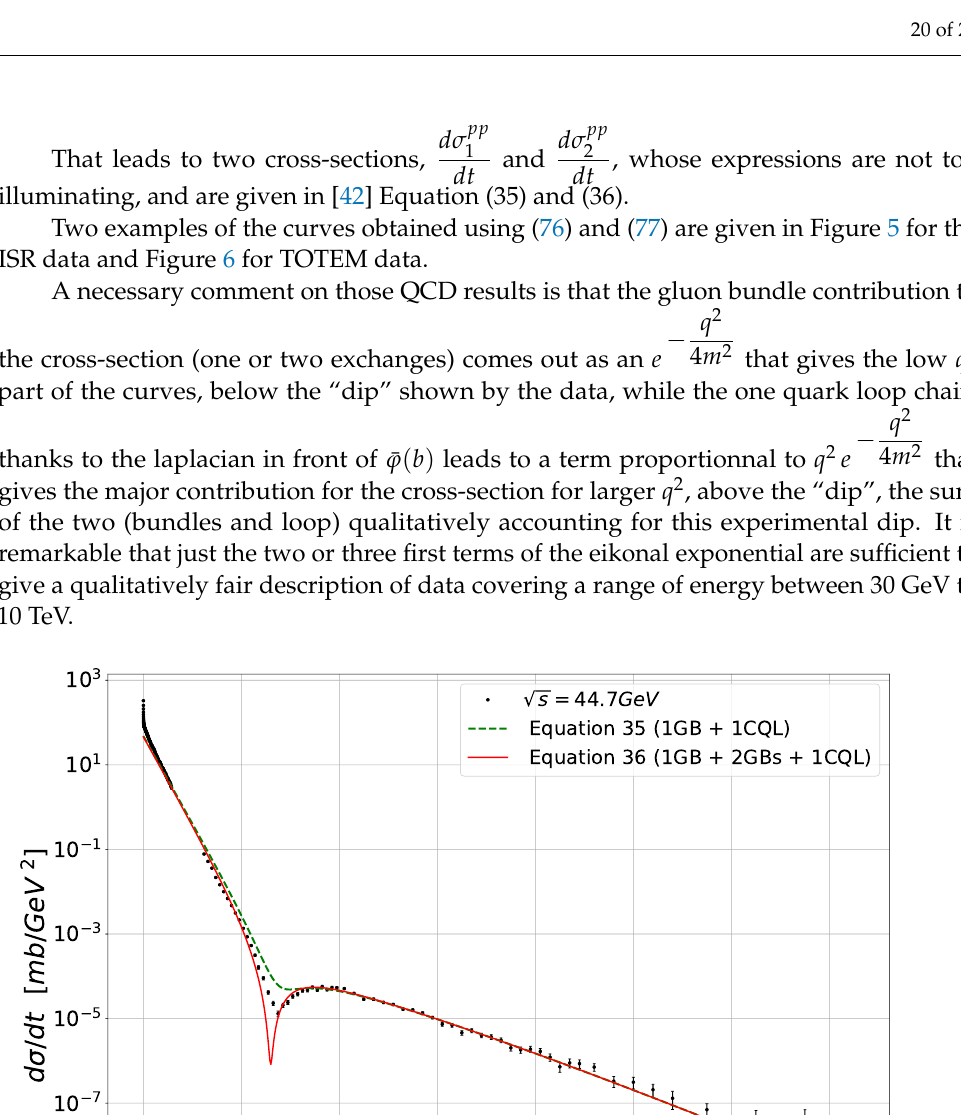
Figure 5. Elastic pp scattering differential cross-section at data, dashed line is the result of [42], Equation (35), solid line comes from [42] Equation